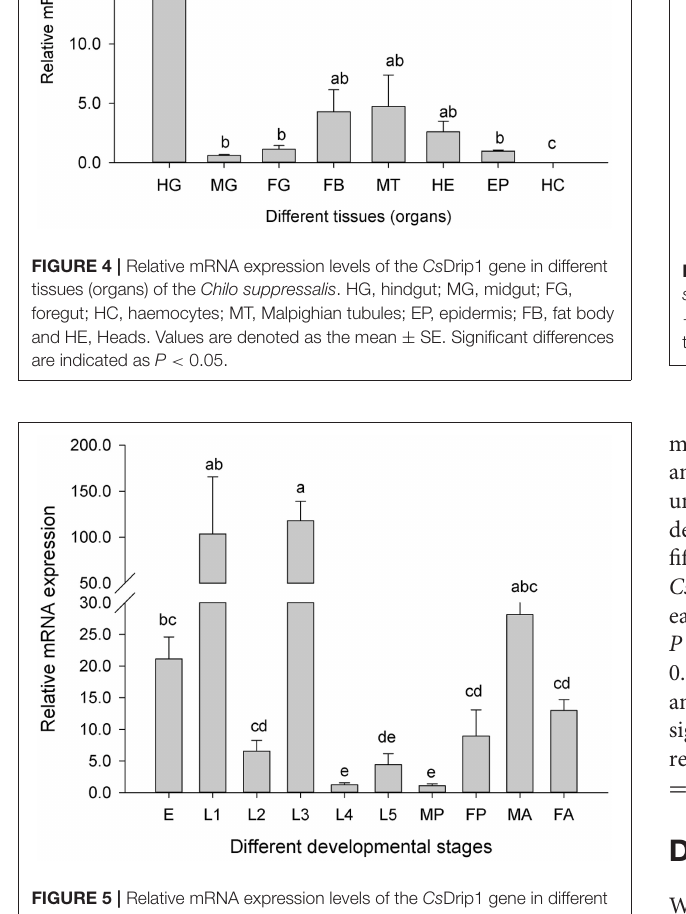
displayed a different expressional pattern under heat stress. For example, Cs Drip1 mRNA reached maximum at 36 ◦ C, which was 3.75-fold of that at control temperature (27 ◦ C) [ F (7, 16) = 39.957, P < 0.001]. Subsequently, the abundance of Cs Drip1 mRNA in larvae decreased by the elevated temperature ( Figure 6 ).